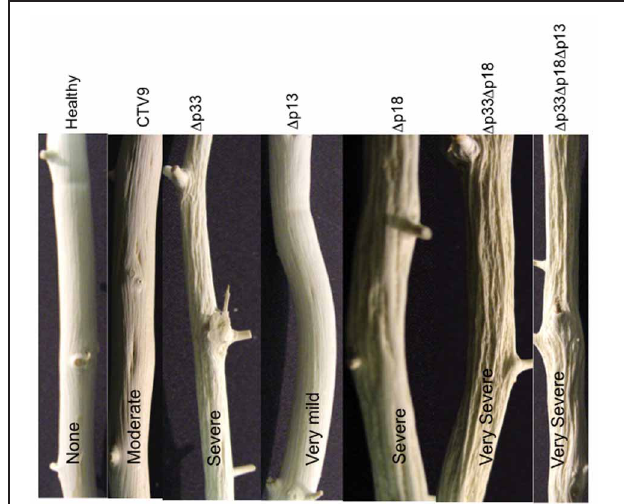
FIGURE 3 | Stems of Citrus macrophylla infected with mutants of CTV with all combinations of deletions of the p33, p18, and p13 genes showing different degrees of stem